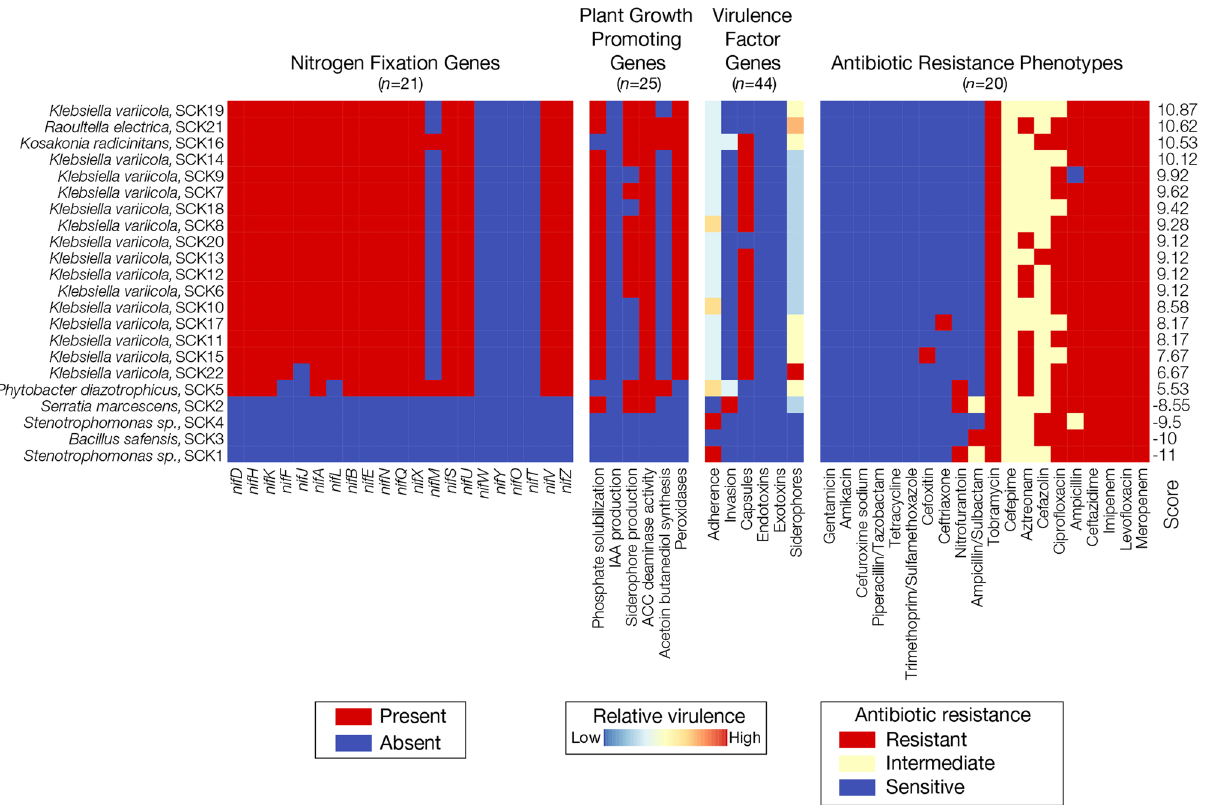
Figure 4. Computational phenotyping of the sugarcane bacterial isolates characterized here. The presence (red) and absence (blue) profiles for nitrogen fixation genes, plant growth promoting genes, and virulence factor genes are shown for the 22 bacterial isolates. Results are shown for all n = 21 nitrogen-fixing genes. Results for plant growth promoting genes ( n = 25) and virulence factor genes ( n = 44) are merged into six gene categories each. Predicted antibiotic resistance profiles are shown for n = 20 antibiotic classes. Detailed results for gene presence/ absence and predicted antibiotic resistance profiles are shown in Supplementary Table S2. The results for all four phenotypic classes of interest were merged into a single priority score for each isolate (right side of plot), as described in the “Methods”, and used to rank the isolates with respect to their potential as